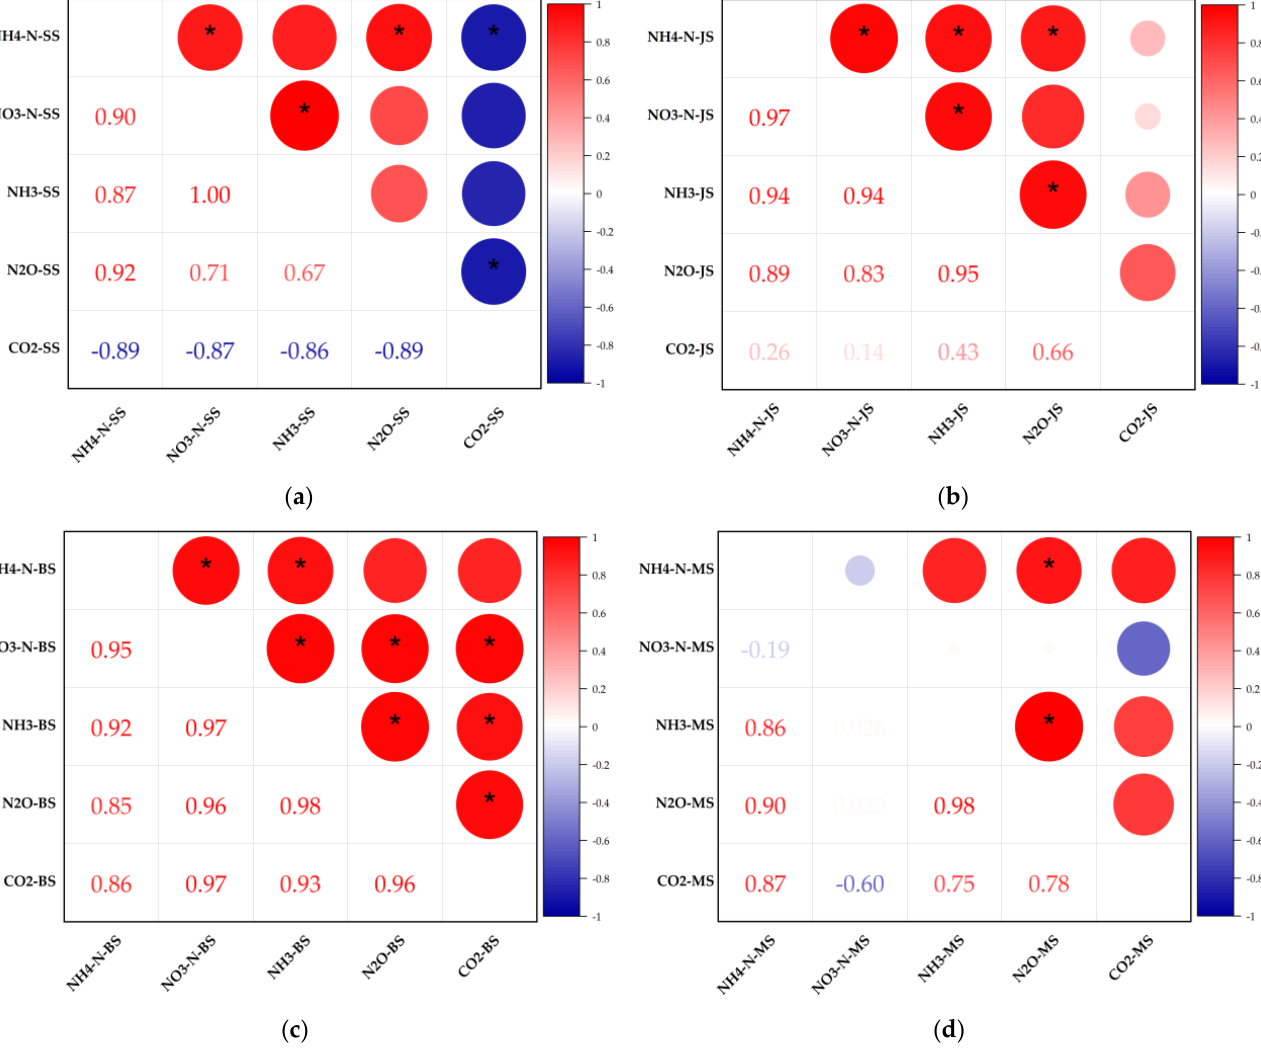
Figure 10. Pearson correlation analysis of soil NH 4 + -N, NO 3 − -N, NH 3 volatilization, N 2 O and CO 2 emission rate in different growth stages ( a ) Seeding stage, ( b ) Jointing stage, ( c ) Booting stage, ( d ) Mature stage of wheat. Note: SS, seeding stage; JS, jointing stage; BS, booting stage; MS, mature stage.